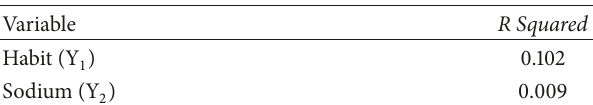
Table 4: R Squared